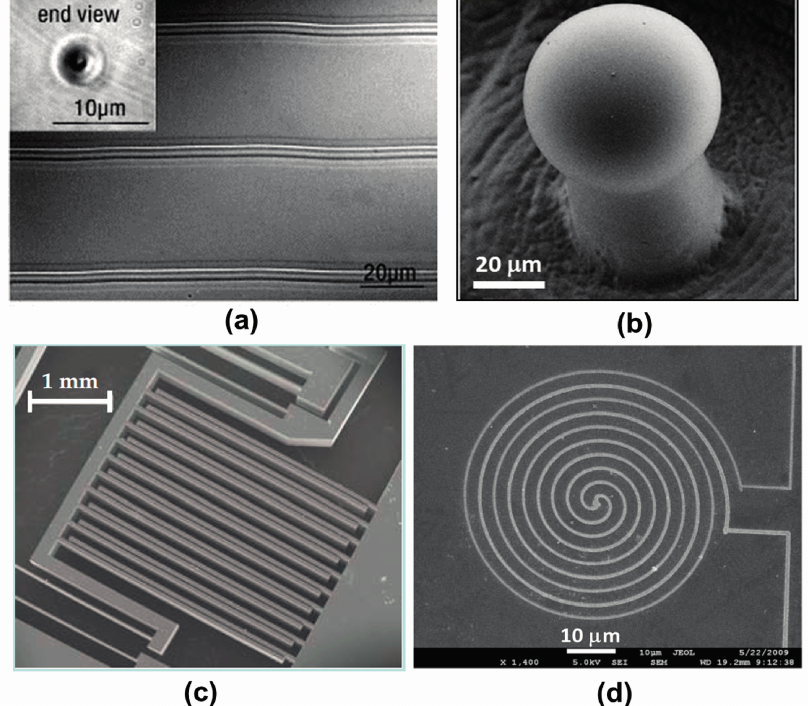
Figure 10. ( a ) Optical micrograph of an oscillator-only femtosecond-laser-micromachined waveguide inside bulk glass. The inset shows one end-face of the waveguide [80] (Reproduced with permission from OSA. © 2001 by the Optical Society of America); ( b ) SEM image of a spheroidal optical microcavity fabricated in glass using FsLDW [104] (Reproduced with permission from OSA. © 2013 by the Optical Society of America); ( c ) SEM image of a micro-actuator fabricated from a single piece of fused silica by femtosecond laser micromachining combined with chemical etching [105] (Reproduced with permission from AIP. © 2012 by the American Institute of Physics); ( d ) SEM image of a patterned silver microcircuit on a glass substrate produced by femtosecond-laser-induced electroless plating [106] (Reproduced with permission from Wiley. © 2010 Wiley-VCH Verlag GmbH & Co. KGaA, Weinheim).